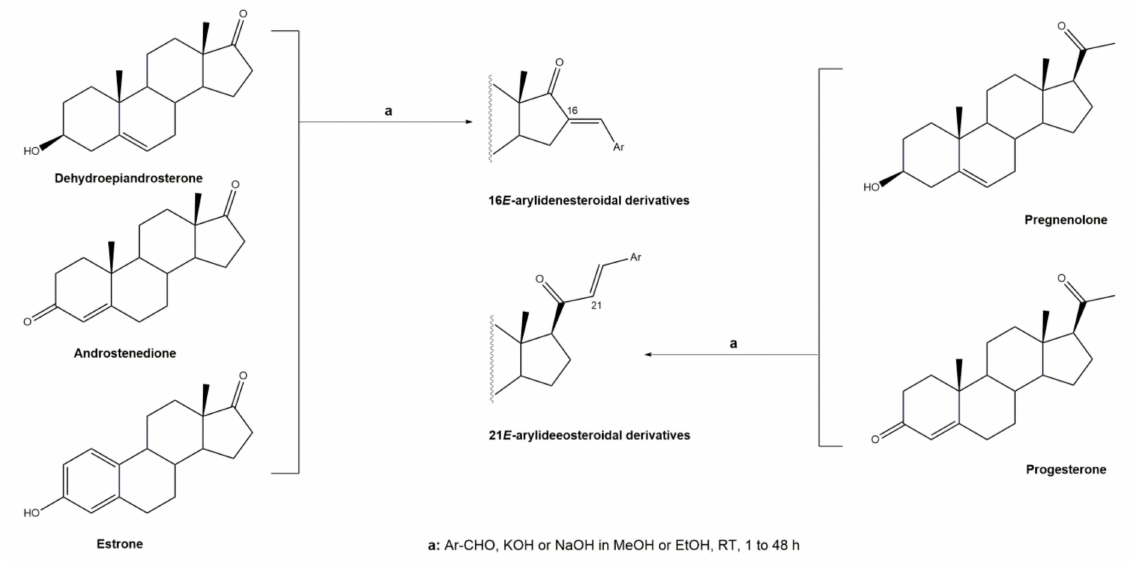
Figure 1. Claisen–Schmidt condensation to prepare 16 E - and 21 E